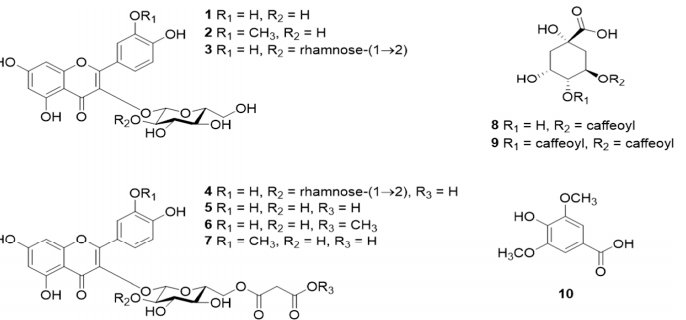
Figure 1. Chemical structures of constituents of CO. ( 1 ), isorhamnetin 3-O- β -glucoside ( 2 ), quercetin 3-O- β -neohesperidoside ( 3 ), quercetin 3-O-(2 ″ -O- α -rhamnosyl-6 ″ -O-malonyl)- β -glucoside ( 4 ), quercetin 3-O-(6 ″ -O-malonyl)- β -glucoside ( 5 ), quercetin 3-O-6 ″ -O-methyl malonyl)- β -glucoside ( 6 ), isorhamnetin 3-O-(6 ″ -O-malonyl)- β -glucoside ( 7 ), chlorogenic acid ( 8 ), 3,4-dica ff eoylquinic acid ( 9 ), and syringic acid ( 10 ). Adapted from [84] under Creative Commons CC BY license (CC BY 4.0) For the extraction of CO, numerous conventional and novel techniques are available. Conventional techniques used in past decades are hydrodistillation, solvent extraction, steam distillation, acid-catalyzed extraction, maceration, expression, and soxhlet extraction [85–89]. The most common solvents used in these processes are methanol, ethanol, acetone, and hexane. Here, due to the presence of high phenolic content, solvents with high polarity are employed; for example, 80% methanol, when used in the extraction process, leads to higher output in terms of the components yield [15,23,90]. Nevertheless, these conventional techniques are challenging because of prolonged extraction time, temperature, and pressure conditions. Here novel techniques such as ultrasound-assisted extraction, microwave-assisted hydrodistillation, microwave distillation, headspace solid- phase microextraction, and headspace–cold fi nger extraction come into the picture, which support numerous aspects such as enhanced extraction, in terms of yield and quality of extracts, and economical as well as ecological advantages [86,91–94]. 3. Therapeutic Applications of Calendula o ffi cinalis Many ailments have been treated with CO; a plant frequently used in homeopathic medicine. Additionally, it can be cytotoxic and inhibit tumor growth [95]. It functions as an antimicrobial [56,96], antioxidant [97], anti-in fl ammatory [89,98], antiseptic [99], anti- viral [89], hepatoprotective [56], and antidiabetic medicine [100]. It is also applied to the skin to treat various conditions, including in fl ammation of the skin, open wounds, and laceration wounds that bleed. Additionally, it is used to heal minor ailments such as razor burns and wind burns. The major parts of the CO plant and their therapeutic applications discussed in this review are represented in Figure 2 and Table 3.